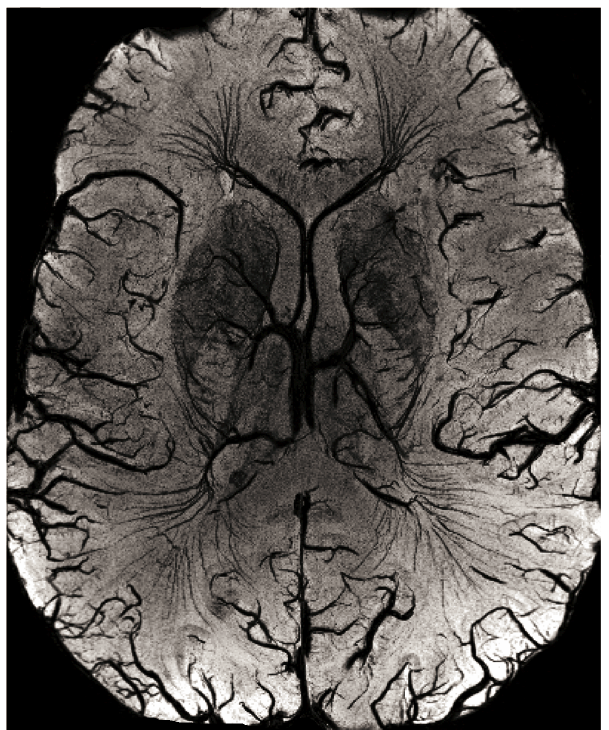
Figure 2. Susceptibility-Weighted Imaging at 7 T (8-channel head coil); this image represents a minimum intensity projection over a 6 mm slab. Note that both, veins and iron containing structures like the basal ganglia appear hypo intense. This image was acquired using an echo time of 15 ms and a resolution of 0.3 × 0.3 × 1.2 mm.